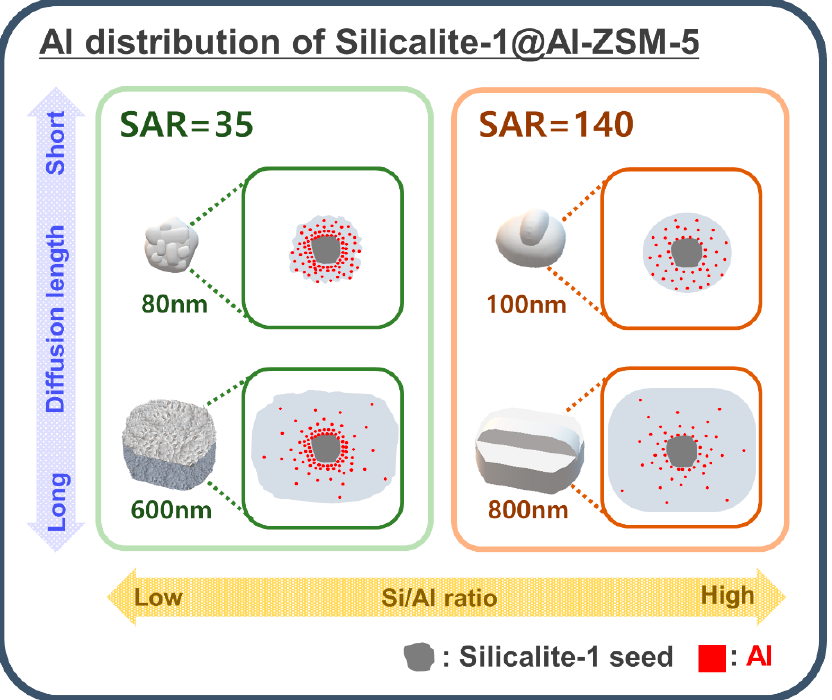
Figure 6. Schematic of Al-distribution of Silicalite-1@Al-ZSM-5 zeolites with different sizes and SARs. Table 2. Elemental analysis results of core–shell zeolites.